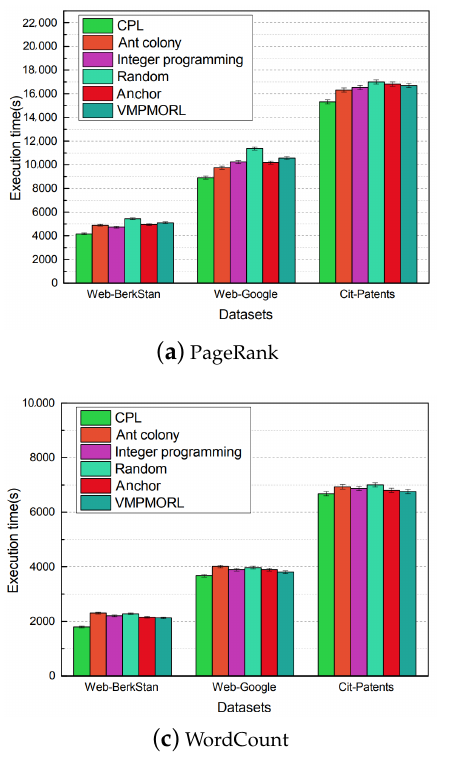
Figure 7. Job execution